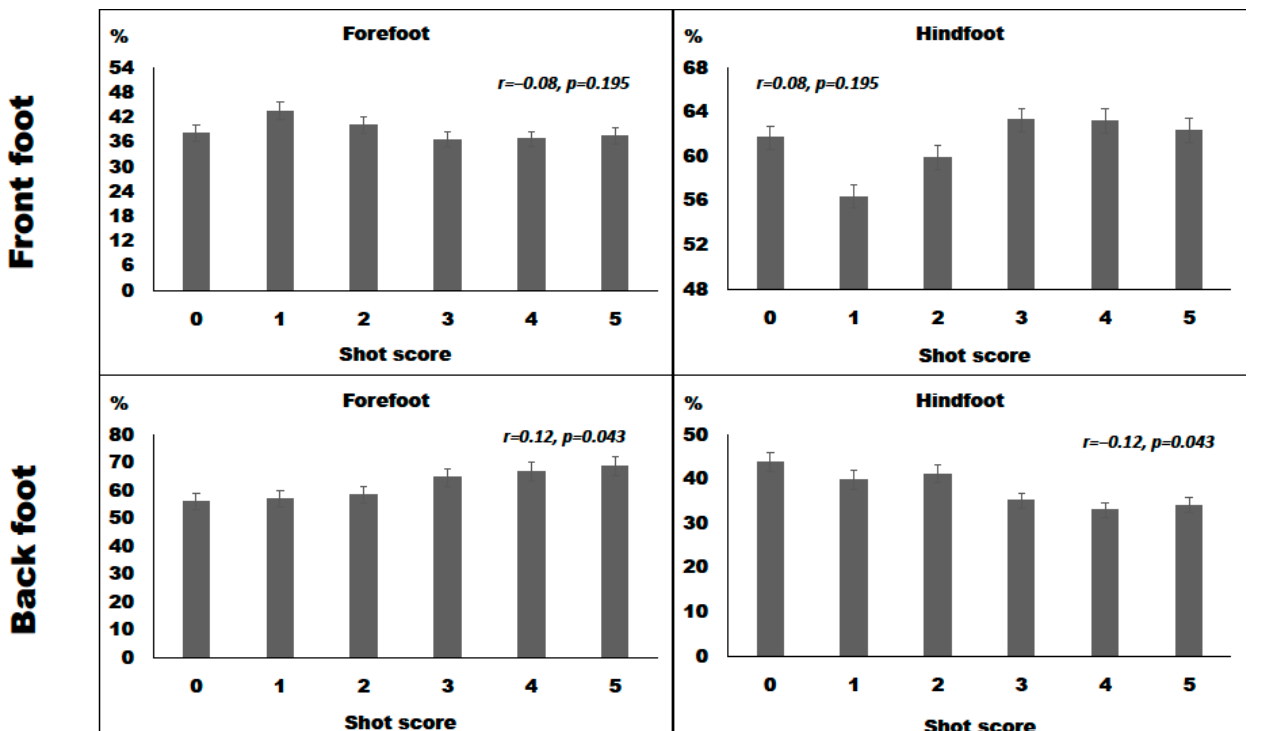
Figure 4. The associations between relative ground reaction forces beneath the forefoot and hindfoot region of both feet with shot score in the study participants.